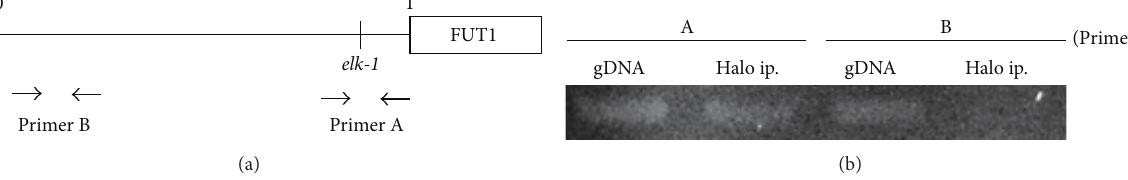
Figure 4: Chromatin immunoprecipitation analysis of FUT1 promoter in DLD-1 cells. Chromatin immunoprecipitation (CHIp) analysis for the Elk-1 binding site region within FUT1 promoter in DLD-1 cells. (a) Primers designed for the 5 󸀠 -flanking region of FUT1 (Primer A: − 140 to − 41, Primer B: − 534 to − 424). (b) DLD-1 cells transfected with pHTC/Elk-1 vector were precipitated and amplified by PCR with specific primers (see (a)) as described in Section 2. gDNA: positive control; PCR amplification for fragmented and nonprecipitated genomic DNA from DLD-1 cells 24 h aftertransfection of Halo-tagged Elk-1 gene. Halo ip: PCR amplification for fragmented and precipitated genomic DNA with Halo resin from the DLD-1 cells 24 h aftertransfection of Halo-tagged Elk-1